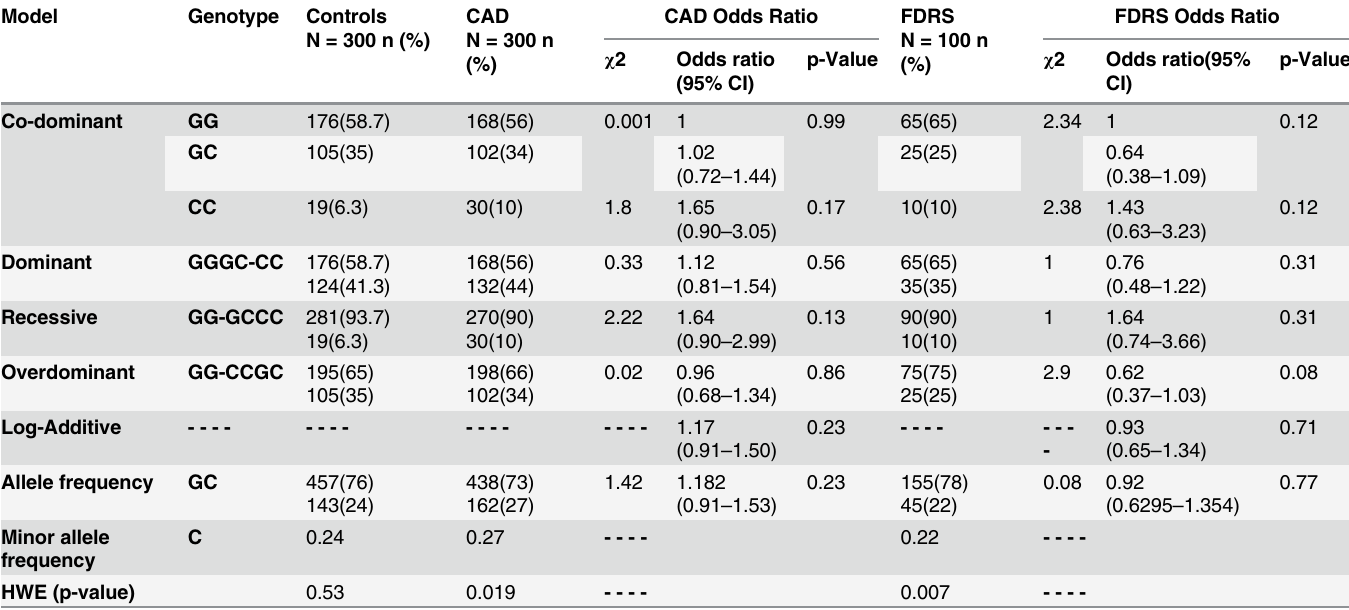
Table 2. Genotype distribution of IL 18 – 137 G/C polymorphism in Controls, CAD patients and FDRS (N = 700).